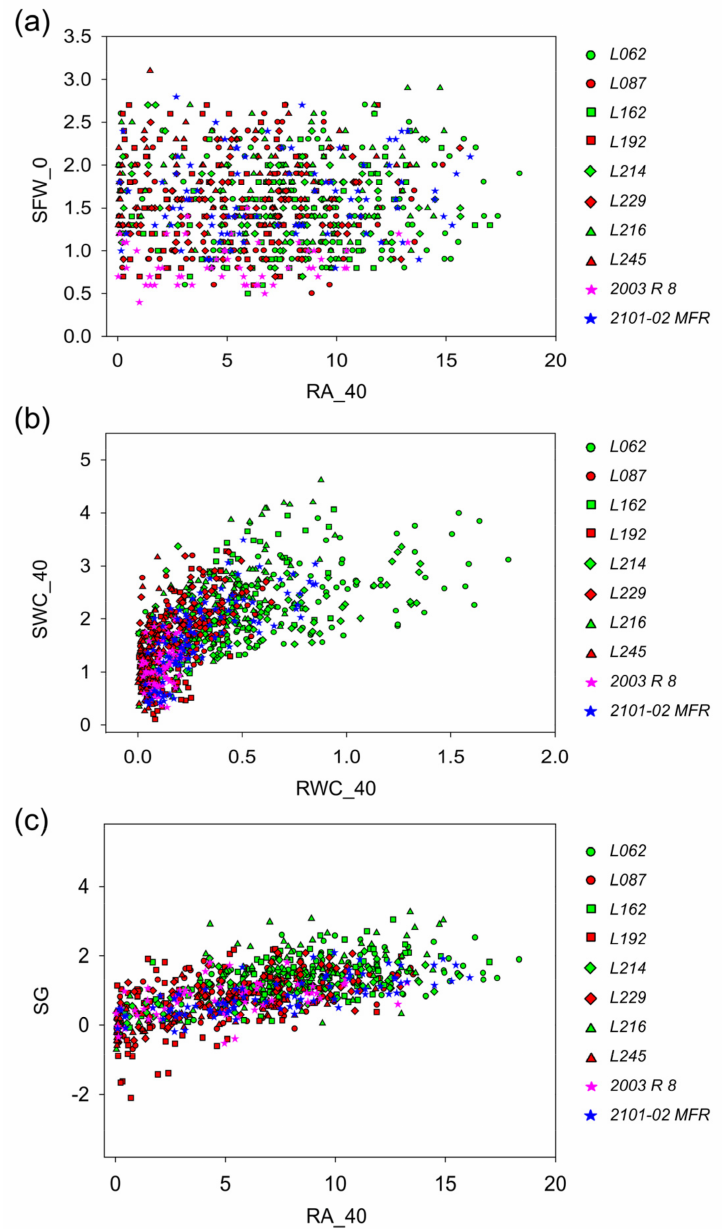
Figure 5. Parameter correlation observed in the third experiment for di ff erent physiological traits in the studied lines. Relationship between ( a ) the final root area (cm 2 ) and the initial shoot fresh weight (g), ( b ) the root water content (g) and the shoot water content (g) and ( c ) the root area (cm 2 ) and the final root growth. Each color and shape indicates one F 1 studied line (good rooting lines in green and bad rooting lines in red), including parental lines